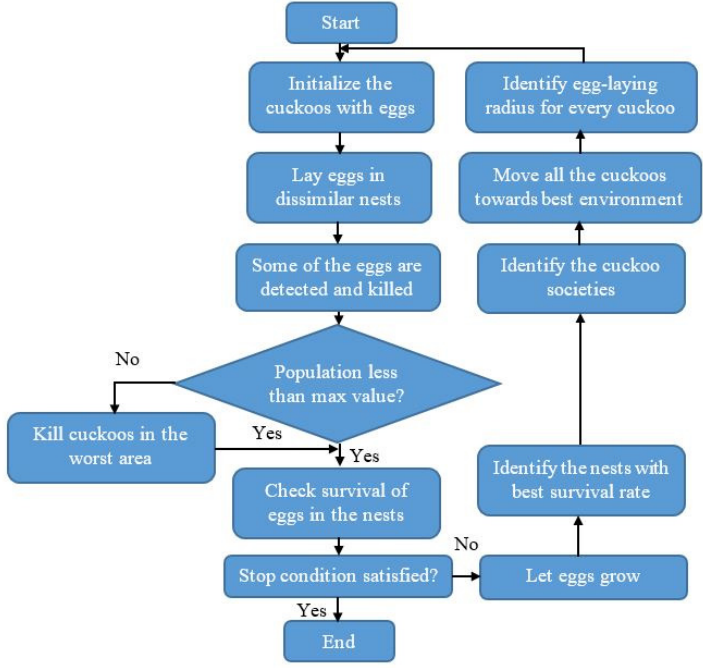
Figure 5. Flowchart of the binary cuckoo search algorithm.